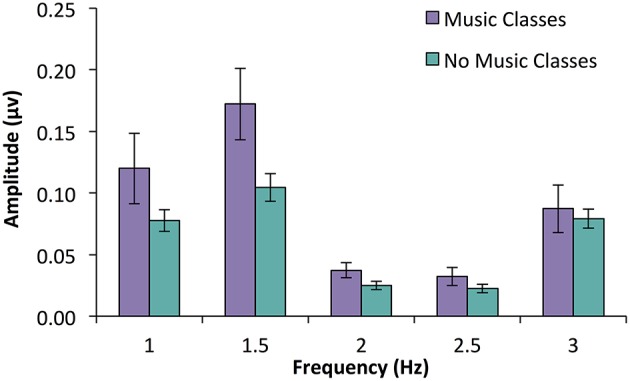
SS-EP amplitudes (noise subtracted, averaged across all channels) across frequencies of interest for 7-month-old infants who have participated in parent-caregiver music classes (n = 13, shown in purple) and infants who have not (n = 46, shown in blue). Infants who have had music classes show larger amplitudes at the duple meter frequency (1.5 Hz) compared to those who do not, p = 0.012. Interestingly, there was no significant difference at beat frequency (3 Hz), p = 0.656.